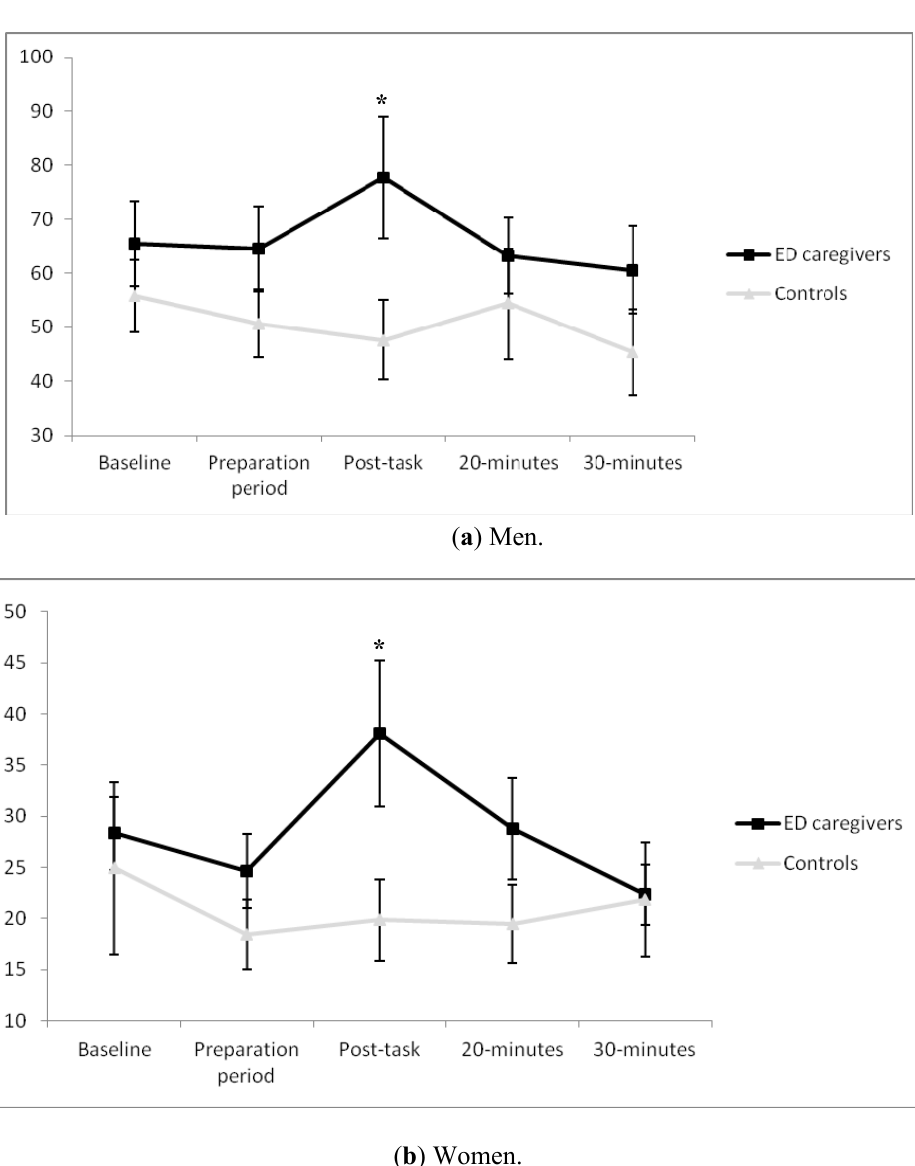
Figure 1. Testosterone levels (pmol/L) in ED caregivers and control groups for men ( a ) and women ( b ) * p < 0.05.